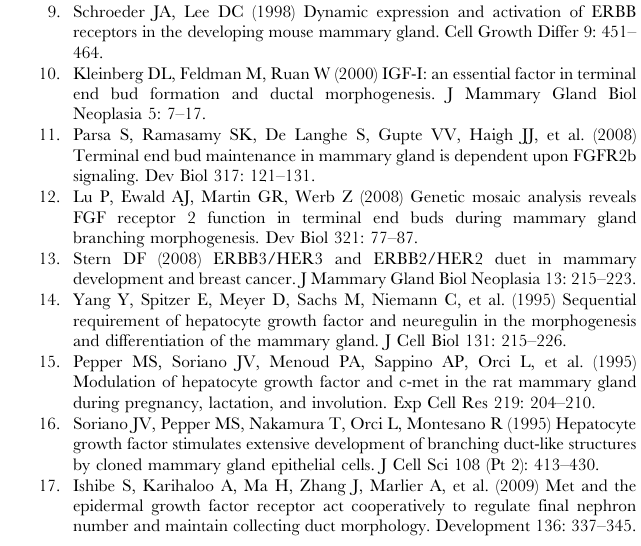
Figure S5 Viable cell count by trypan-blue exclusion staining at 48 h of MCF-10A and ErbB2 tumor cells cultivated in growth medium and the indicated inhibi- tors (AG/A = AG1478 250 nM; UO/U= UO126 15 m M; WORT/W = Wortmannin 100 nM) in presence or ab- sence of HGF 10 ng/ml (H). Untreated control (Ctrl) was set to 100%. %. Columns, mean (n= 6); bars, S.E.M. *P , 0.05. (TIF) Video S1 NMuMG cells stably expressing EGFP were grown in collagen for 2 days. Cells were then treated with AG1478 250 nM and time lapse acquisition (48 h; 100x magnification) was made using a computer controlled Leica AF6000LX inverted microscope equipped with a motorized stage controlled by the LAS AF software. (MOV) Video S2 NMuMG cells cultured as in Video S1 were treated with the indicated factors (HGF 10 ng/ml; AG1478 250 nM) and time lapse acquisition was made as in Video S1. (MOV) Video S3 MCF-10A cells were starved overnight in medium containing 5% horse serum and then treated with the indicated factors (10 ng/ml). Time lapse acquisi- tion (6 h; 50 6 magnification) was made using a computer controlled Leica AF6000LX inverted microscope equipped